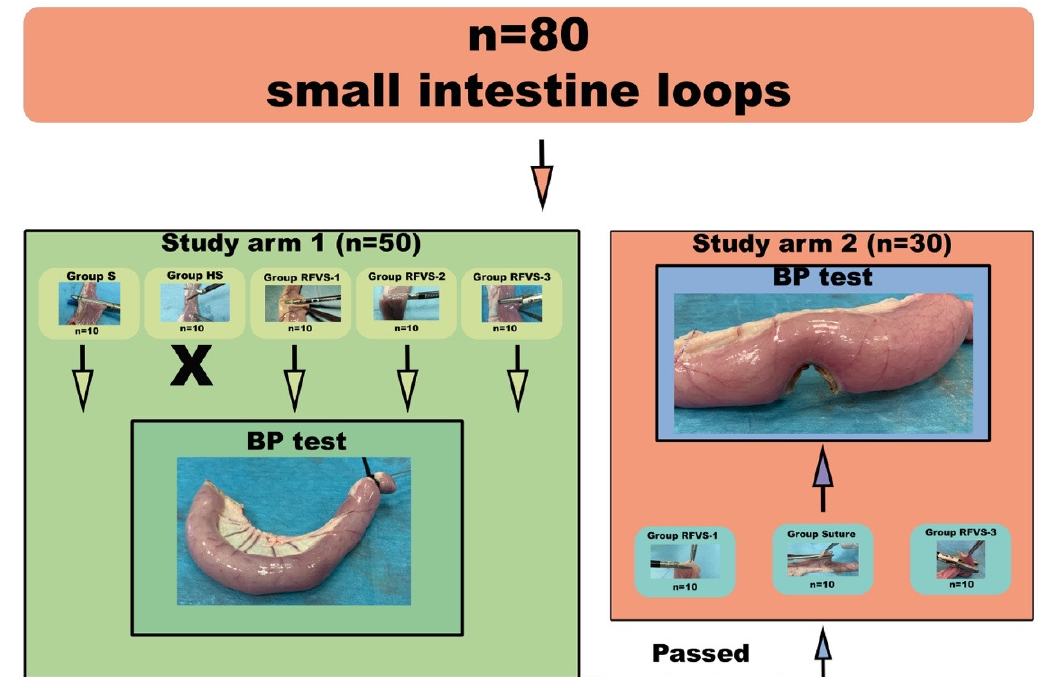
Figure 1. Study design. Eighty swine intestinal loops were randomly assigned to each experimental group (n = 10 each). Group S, Stapler; Group HS, Harmonic Scalpel; Group RFVS-1, LigaSure 5-mm Dolphin tip; Group RFVS-2, ENSEAL; Group RFVS-3, LigaSure Atlas 10-mm; BP, Burst Pressure. Group HS was not tested for maximum BP because it failed closure in all specimens. Devices provided adequate sealing in study arm 1 passed to study arm 2.